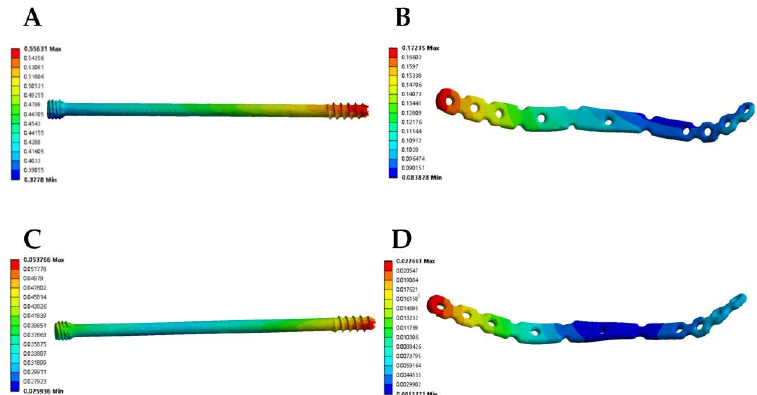
Figure 4. The maximum total displacement in Tile b2 pelvic fracture under different fixation modes (( A ) anterior ring hollow compression screw sitting group; ( B ) anterior ring hollow compression screw standing group; ( C ) anterior ring plate sitting group; ( D ) anterior ring plate standing group ) .